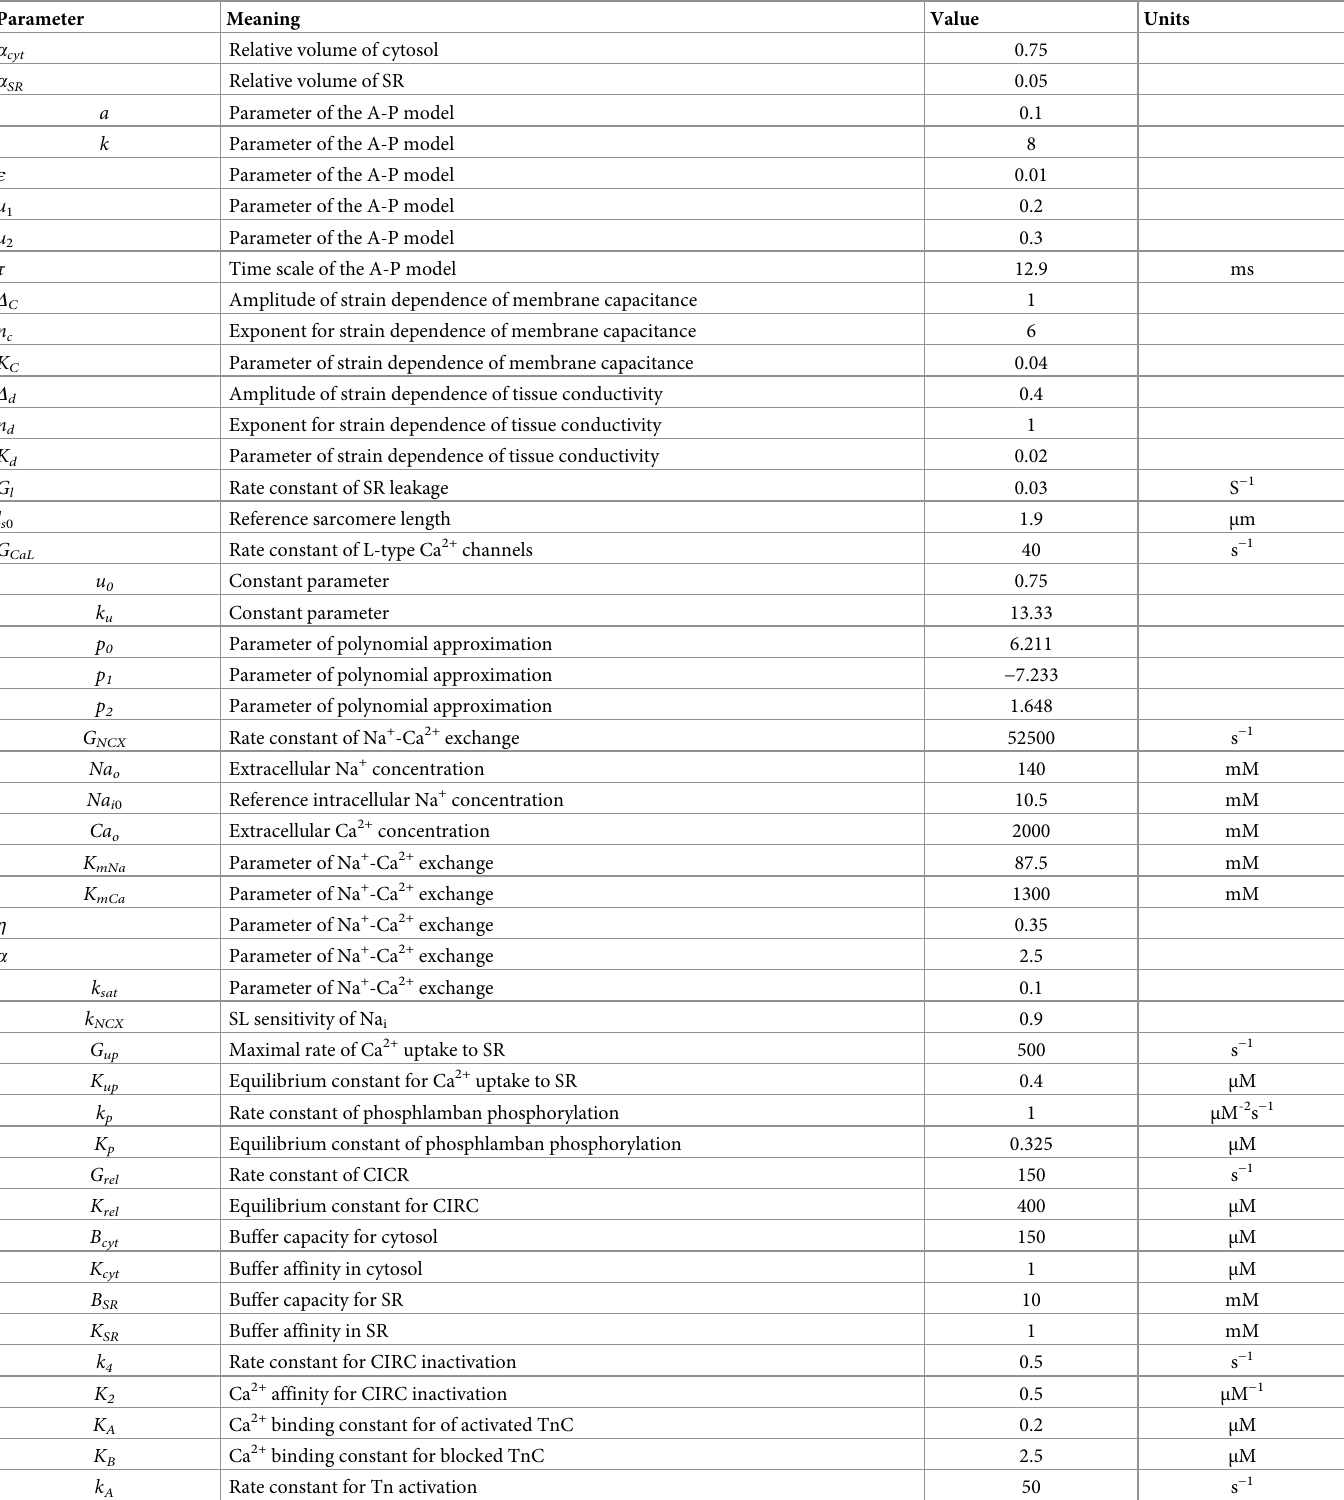
Table 1. The list of the model